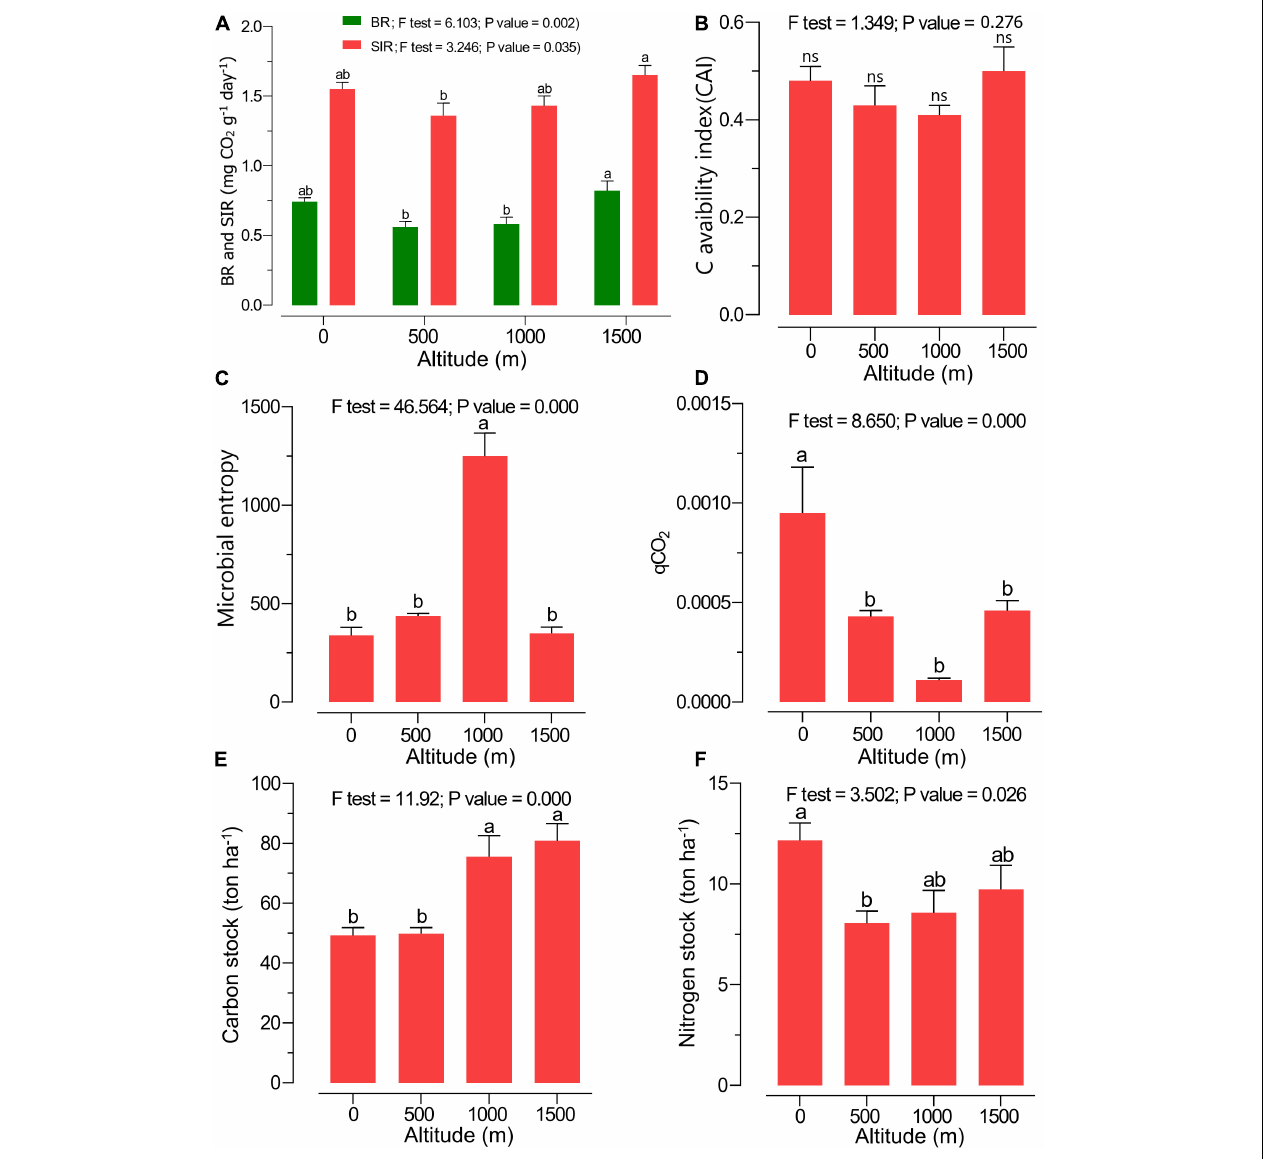
FIGURE 2 | Soil microbial/biochemical properties such as (A) soil basal respiration (BR; green) and substrate-induced respiration (SIR; red), (B) carbon availability index (CAI), (C) microbial entropy ratio, (D) metabolic quotient (qCO 2 ), (E) carbon stock, and (F) nitrogen stock at various altitudes. Different letters indicate a significant difference along the altitudinal gradient [analysis of variance (ANOVA) followed by Tukeys HSD post hoc test; p <